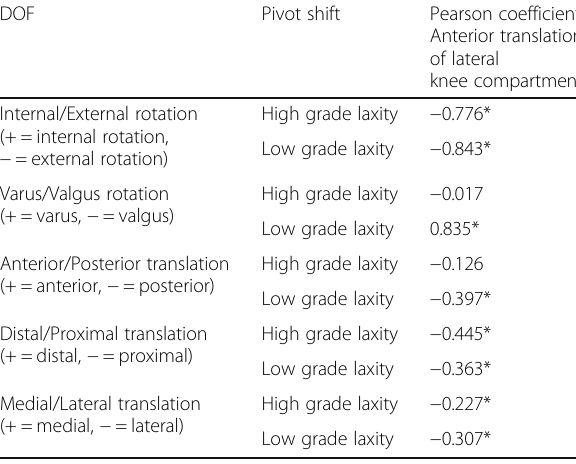
Table 3 Correlation between examiner-induced motion during the reduction event of the pivot shift test and the anterior translation of the lateral knee compartment in the high grade laxity specimen and the low grade laxity specimen